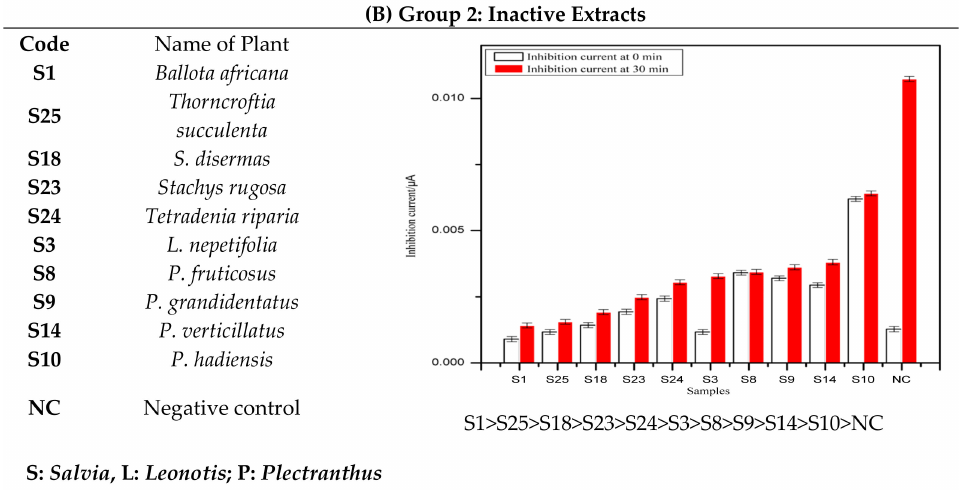
Figure 4. Illustration of the effect of groups on inhibition of tyrosinase enzyme activity. ( A ) Group 1: Active Extracts; ( B ) Group 2: Inactive Extracts. The histograms are expressed as mean ± SEM for n =